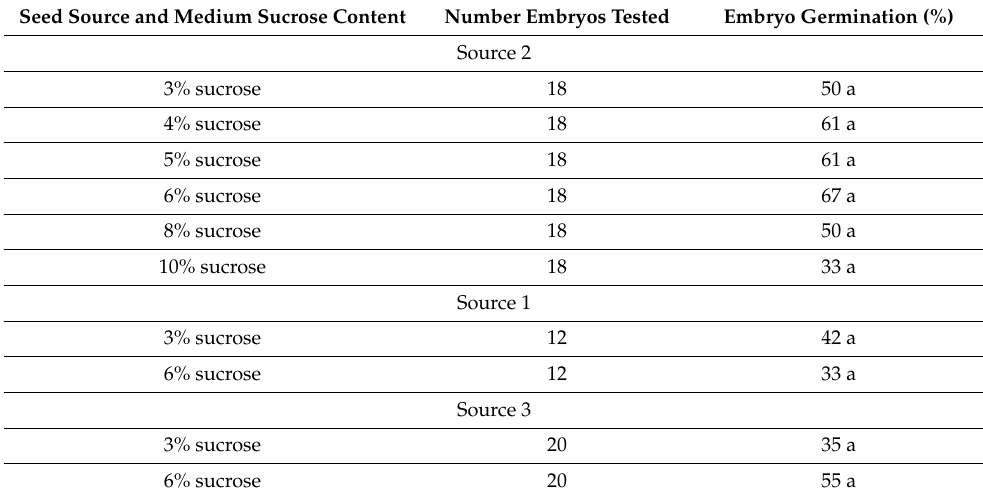
Table 1. Xerophyllum asphodeloides embryo germination percentage for three seed sources (1, 2, and 3) on ½ MS medium without PGRs with different sucrose concentrations after eight weeks.